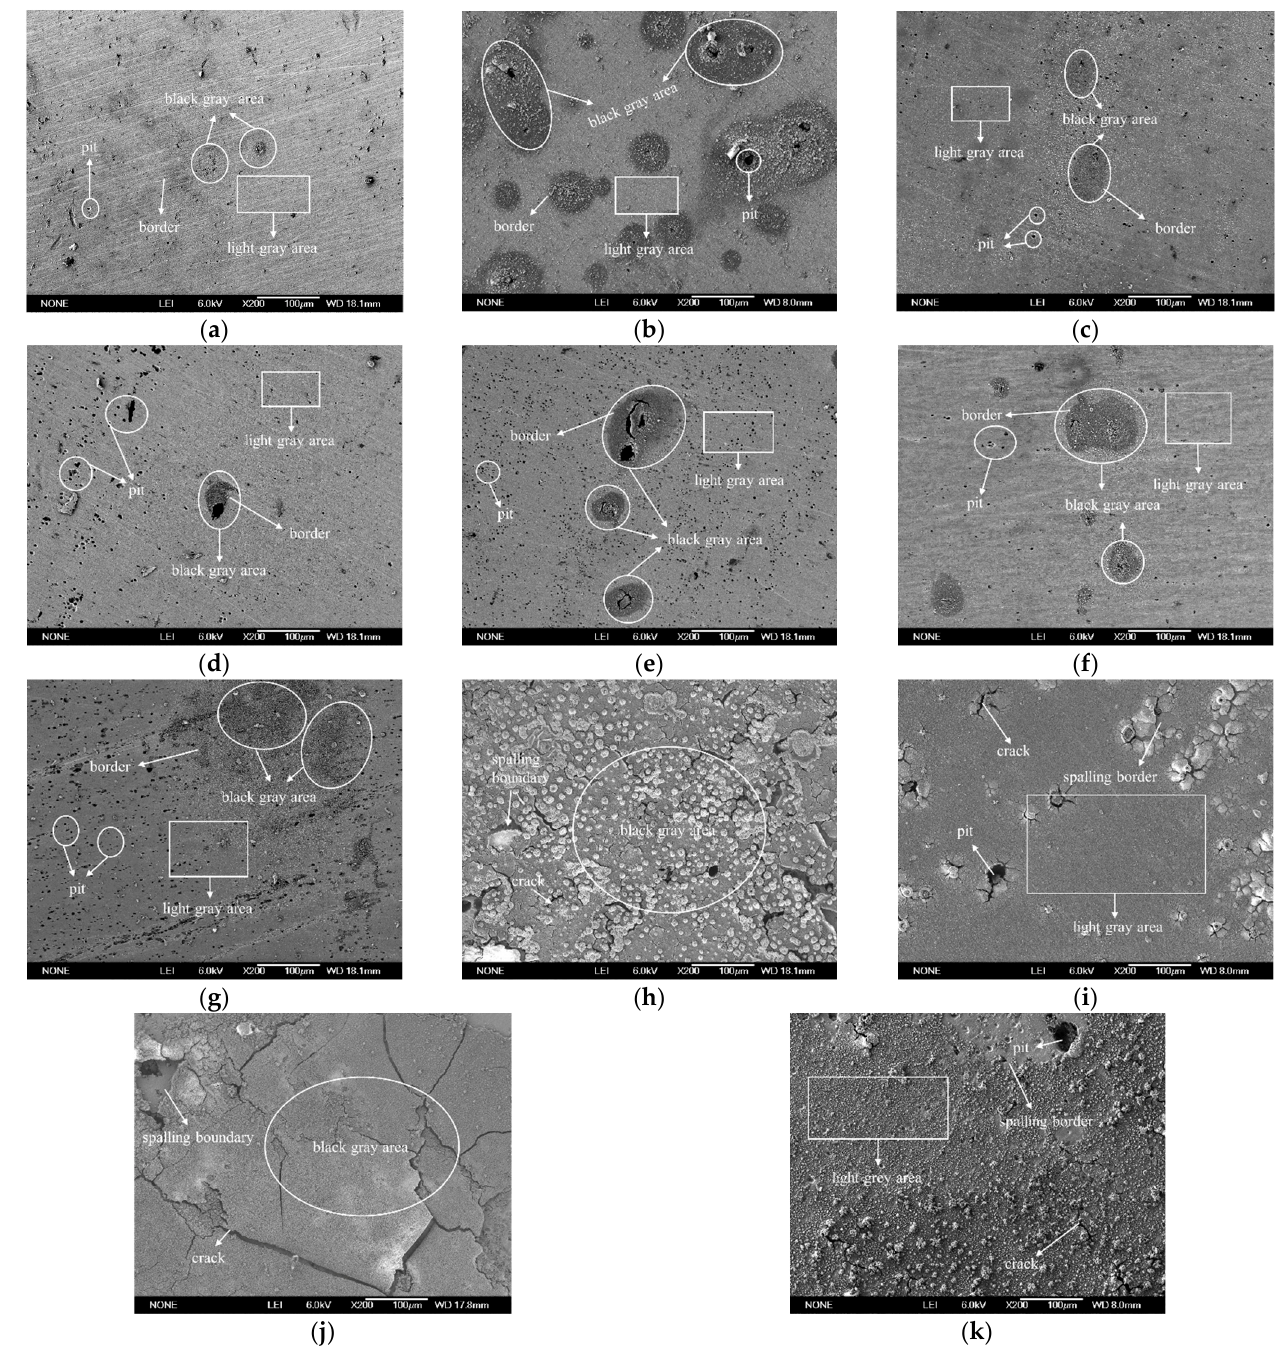
Figure 3. The micro morphology of the pipe wall surface after different corrosion times: ( a ) 10